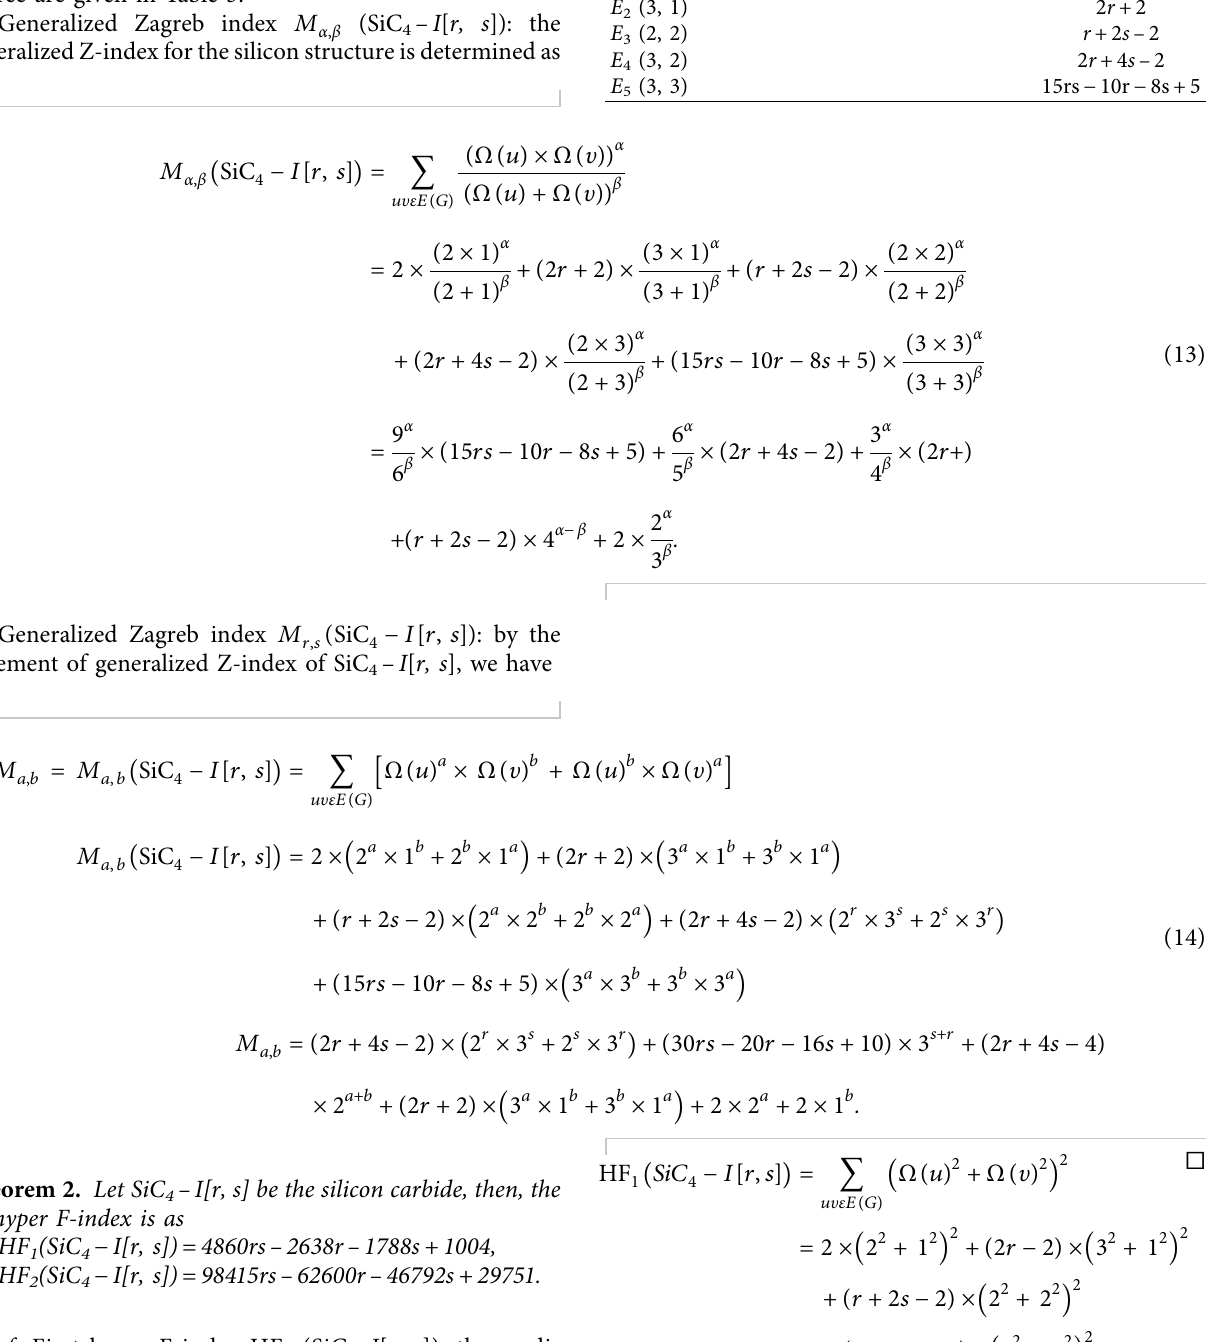
Table 3: Edge division of SiC